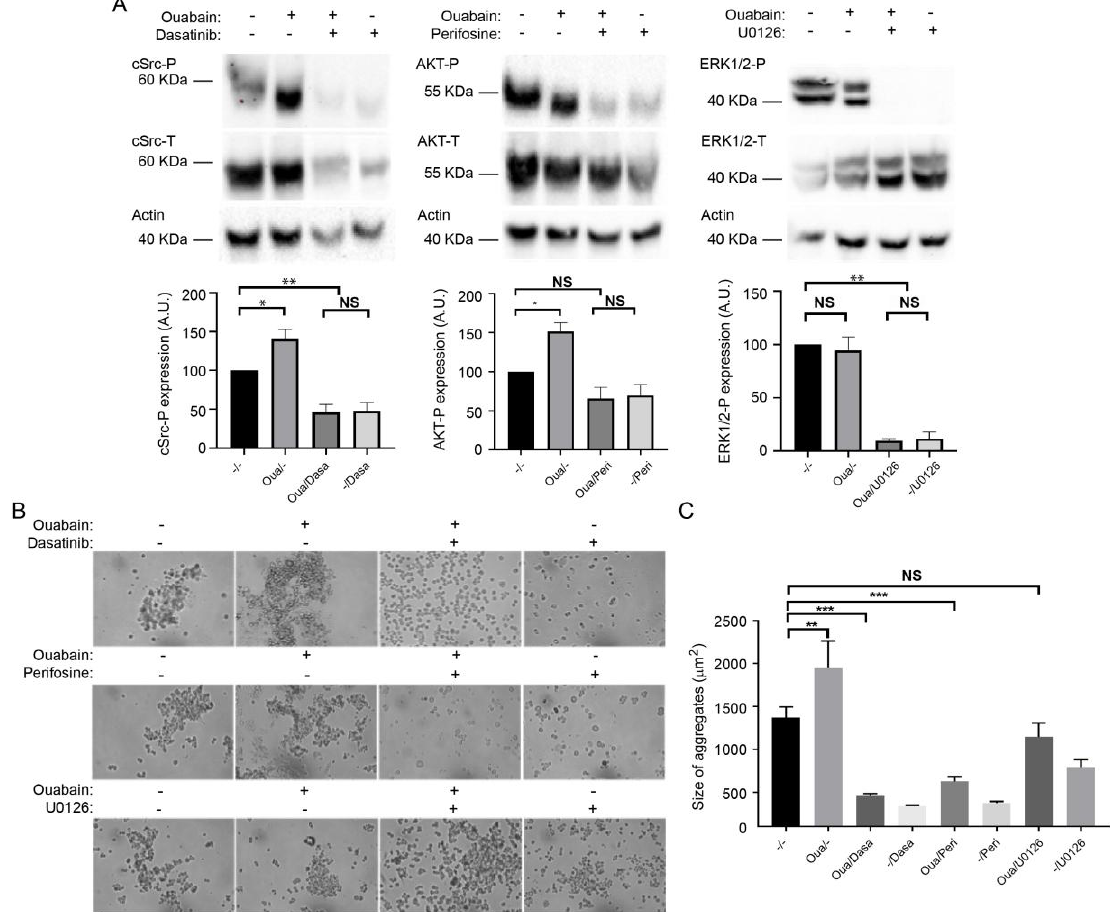
Figure 5. Src and AKT signaling pathways are involved in ouabain modulation of cell-cell adhesion of CHO β 1 fibroblasts. ( A ) Representative Western blot analysis (upper panel) and quantification (lower panel) of cSrc-P, AKT-P, and ERK1 / 2-P of non treated ( − ) CHO β 1 cells, and independent cultures treated with 50 nM ouabain ( + ), and in the presence ( + ) or absence ( − ) of the specific kinase inhibitor: cSrc (Desatinib, 100 nM); AKT (Perifosine, 10 µ M); and EKR1 / 2 (U0126, 10 µ M) ( n = 3). The inhibitors were added 1 h prior to incubation with ouabain for 60 min. NS, non-significant, * p < 0.05, ** p < 0.005. ( B ) Representative images of dispase aggregation assay of untreated control ( − / − ) CHO β 1 and cells treated with 50 nM ouabain and the specific inhibitors for cSrc, Desatinib; AKT, Perifosine; and EKR1 / 2, U0126. Image taken at a magnification 5 × . ( C ) Quantification of the size of cellular aggregates. The data represent the mean of three independent biological replicates ± SE. Kruskal Wallis and Dunn´s test for multiple comparisons were performed. NS, non-significant, ** p < 0.005, *** p < 0.0001